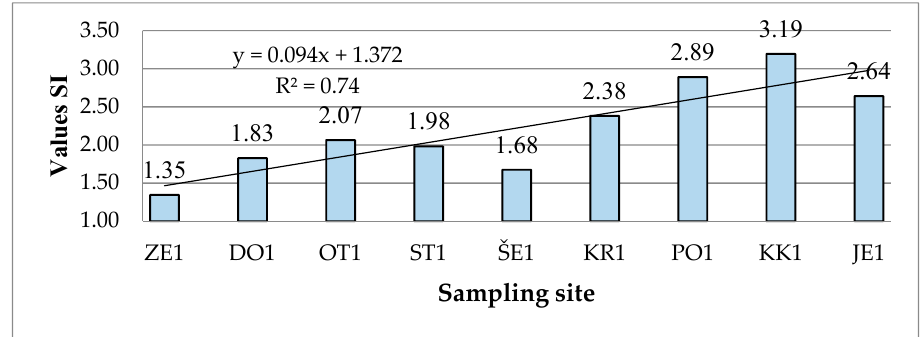
Figure 4. Saprobic index values for all winter samples (Sampling sites are defined in Figure 1).